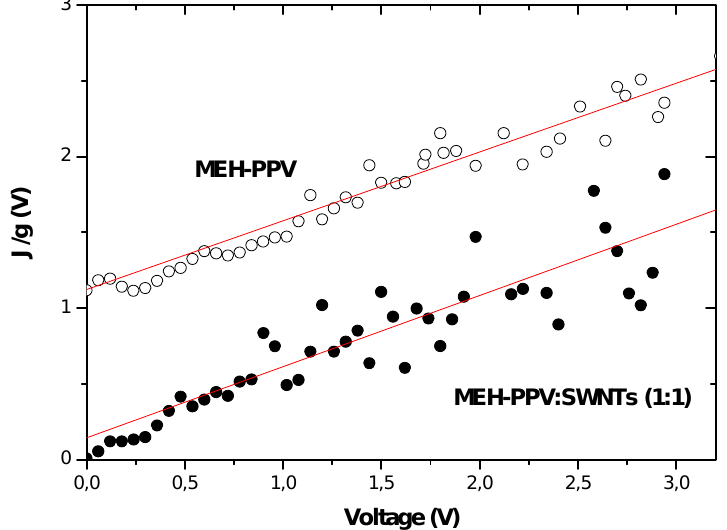
Figure 2. J/g of MEH-PPV and MEH-PPV+SWNTs devices shown in Figure 1 as a function of diode voltage used for the extraction of power parameters and threshold voltage of the SCLC regime. The MEH-PPV curve is shifted by +1 for better readability. The lines are used to determine the